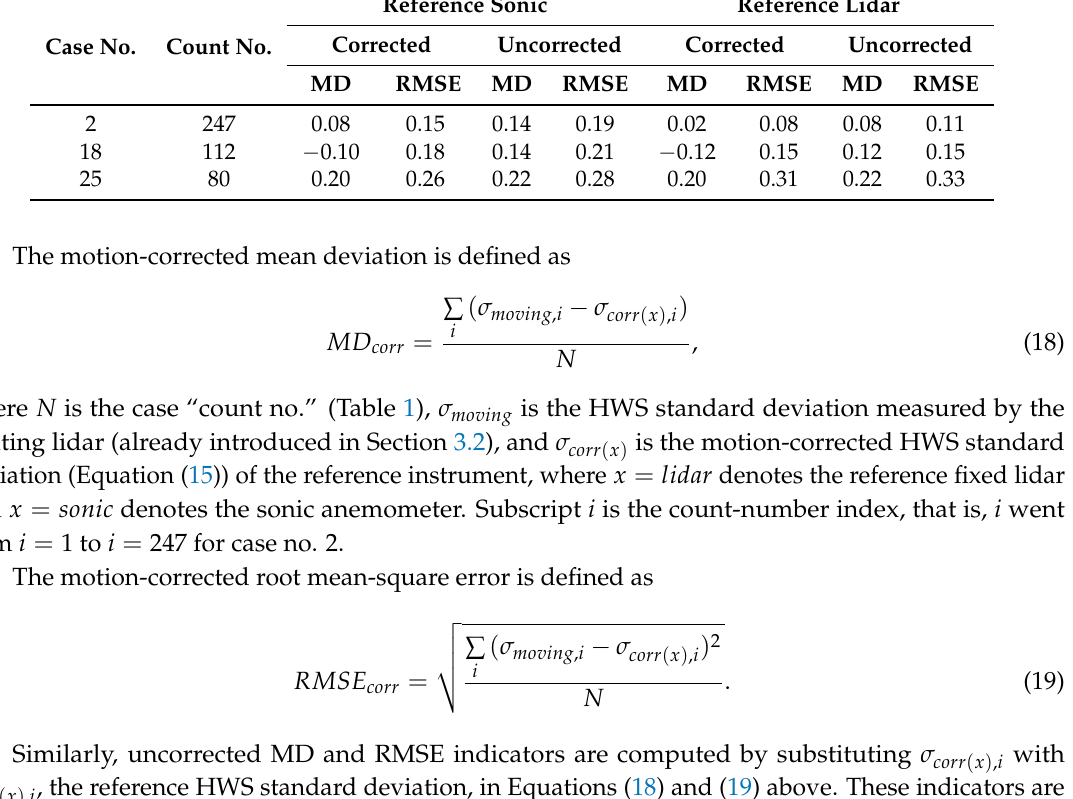
Table 2. Statistical indicators with and without motion correction for the selected discussion case examples from Table 1. MD stands for mean deviation and RMSE stands for root mean square error (see text and Equations (18) and (19)). MD and RMSE units are (m/s). Reference Case No. Count No.